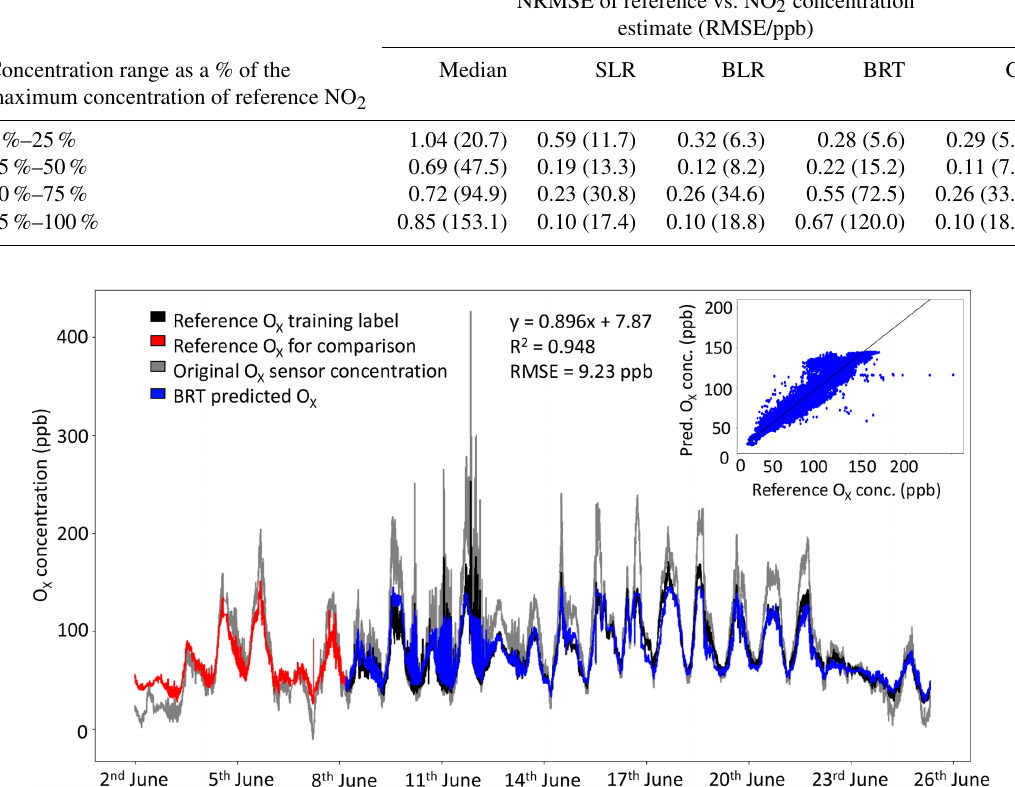
Figure 6. Factory-calibrated median sensor concentration (grey), reference O 3 + NO 2 data (black) and BRT O x prediction (blue) for a cluster of O x sensors. The reference measurements that were used as the training label are displayed in red. Inset: the correlation plot for the testing dataset, comparing the reference data and the BRT-predicted O x sensor